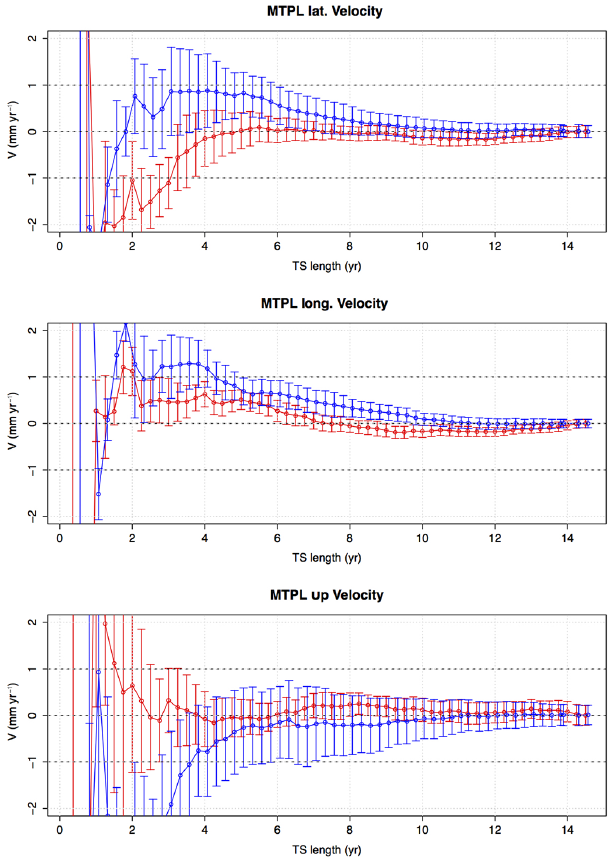
Figure 3. Velocity convergence for the station MTPL for the for- ward (red) and backward (blue)